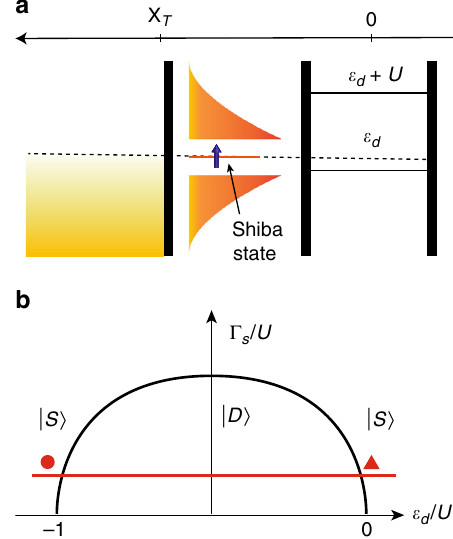
Fig. 6 Phase diagram. a Schematics with all the energies involved. b The typical phase diagram. The dome is the boundary for the stability of the magnetic doublet state (inside) versus the singlet ground state